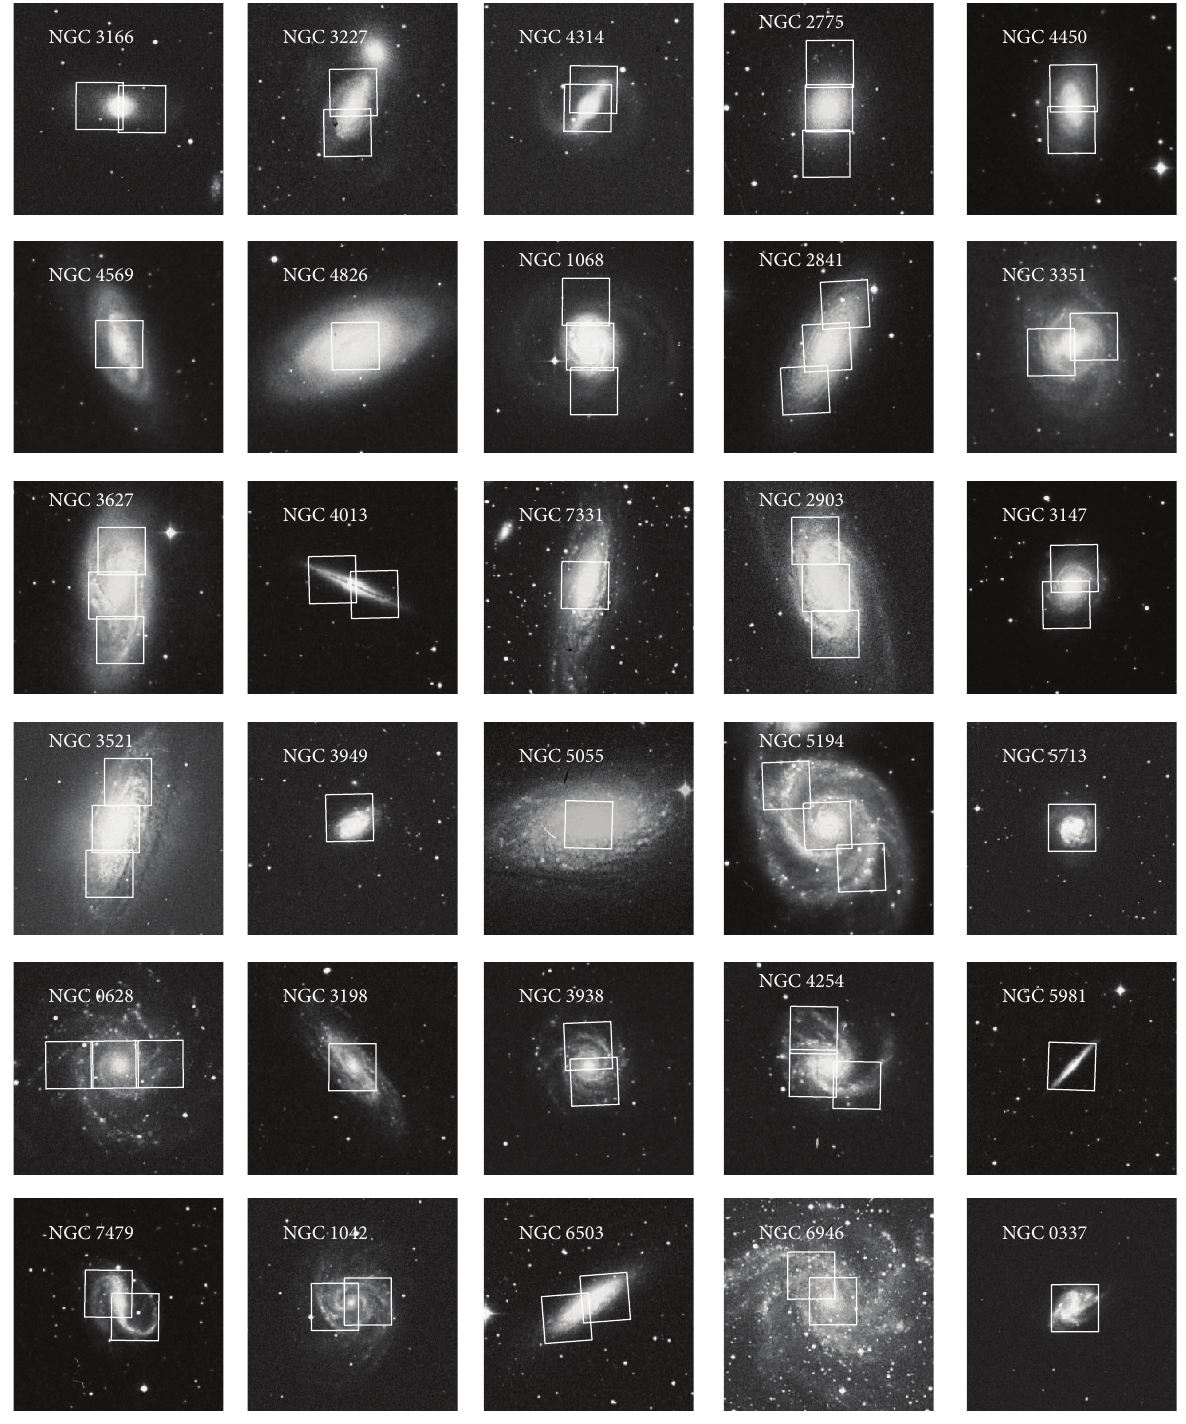
Figure 5: Digital Sky Survey cutouts of the 30 galaxies in the VENGA sample. The targets are ordered by Hubble type (taken from RC3, de Vaucouleurs et al. [94–96]) from earlier to later. White boxes show the VIRUS-P 1.7 󸀠 × 1.7 󸀠 pointing observed on each galaxy. Taken from Blanc et al.